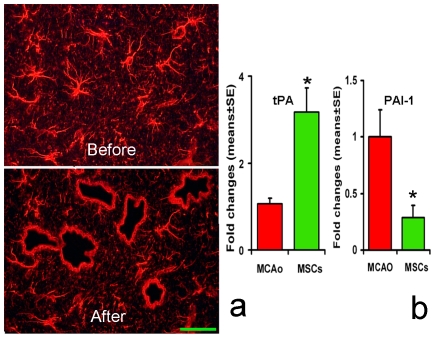
tPA and PAI-1 level in MCAo mouse IBZ astrocytes respond to MSC.(5a) presents the individual IBZ astrocytes dissected using LCM (before and after dissection), and tPA and PAI-1 mRNA level in these astrocytes with or without MSC treatment are shown in (b). MSC treatment significantly increased tPA mRNA level and concomitantly decreased PAI-1 mRNA level. Scale bars = 50 µm. *P<0.05 compared with MCAo mice.